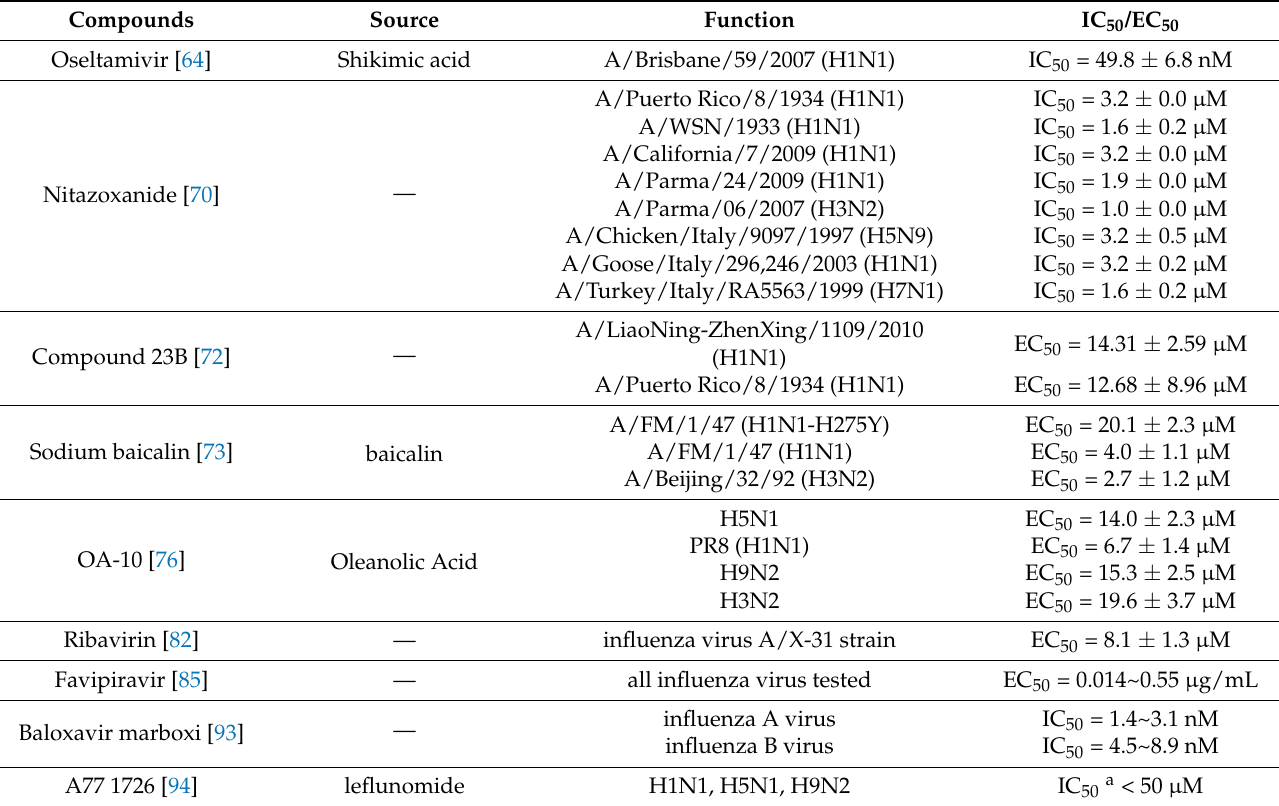
Table 1. List of chemical synthesis